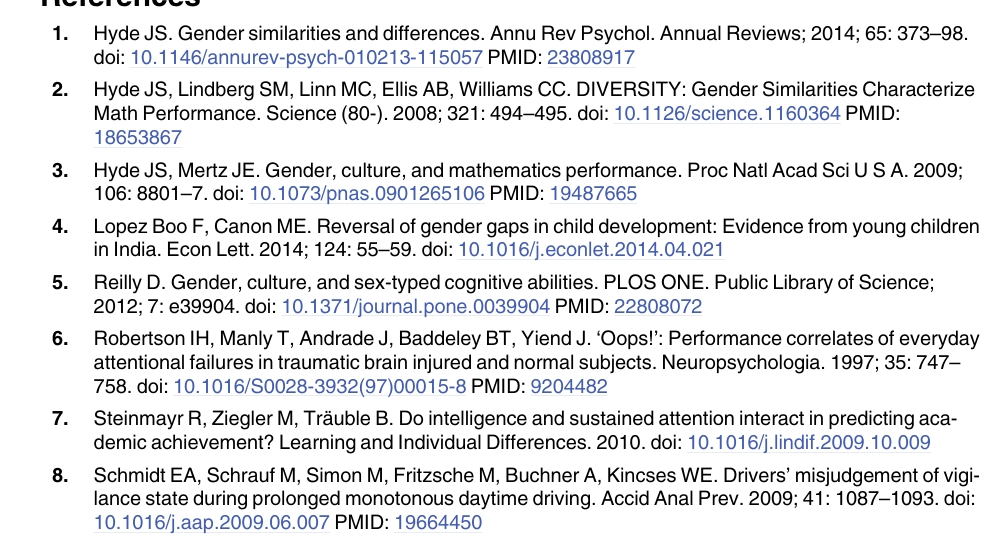
S1 Table. Countries included in our sample, and number of participants(men and women) in each country. S2 Table. Gender (cid:3) socioculturalinteractions in commission error rate when controlling for omission error rate, and vice